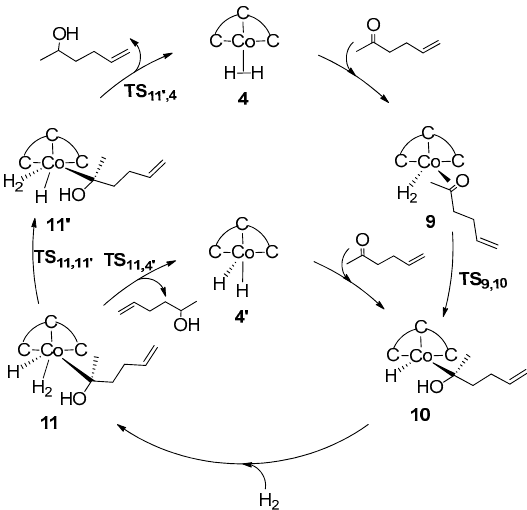
Scheme 4. Proposed catalytic cycle for the hydrogenation of hex-5-en-2-one to hex-5-en-2-ol catalyzed by ( Mes CCC)Co complexes.